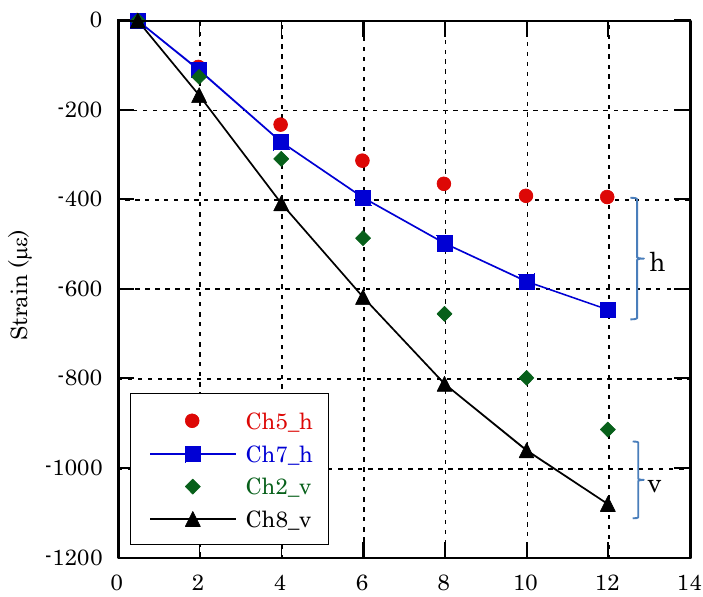
Figure 4. Berea core strain gauge measurements showing considerable differences between the vertical and hoop strains and a bi-linear increase in the strains with increasing confining pressure.